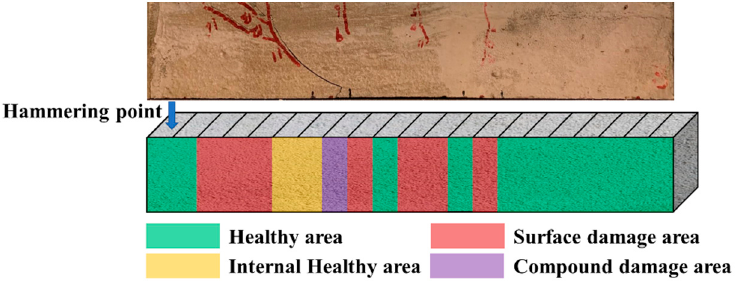
Figure 9. Schematic diagram of the concrete damage area for the four-category classification.